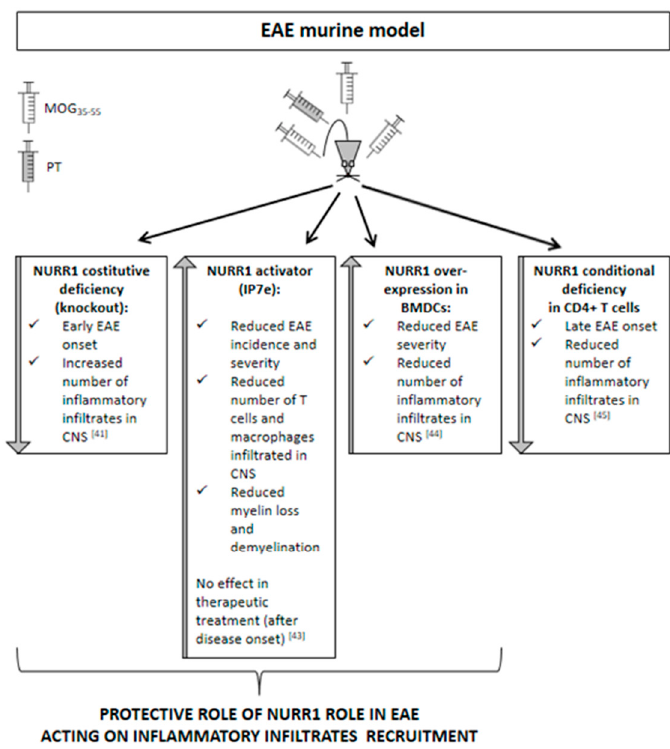
Figure 2. Scheamtic representation of the e ff ects of NURR1 alteration in the experimental autoimmune encephalomyelitis (EAE) murine model.